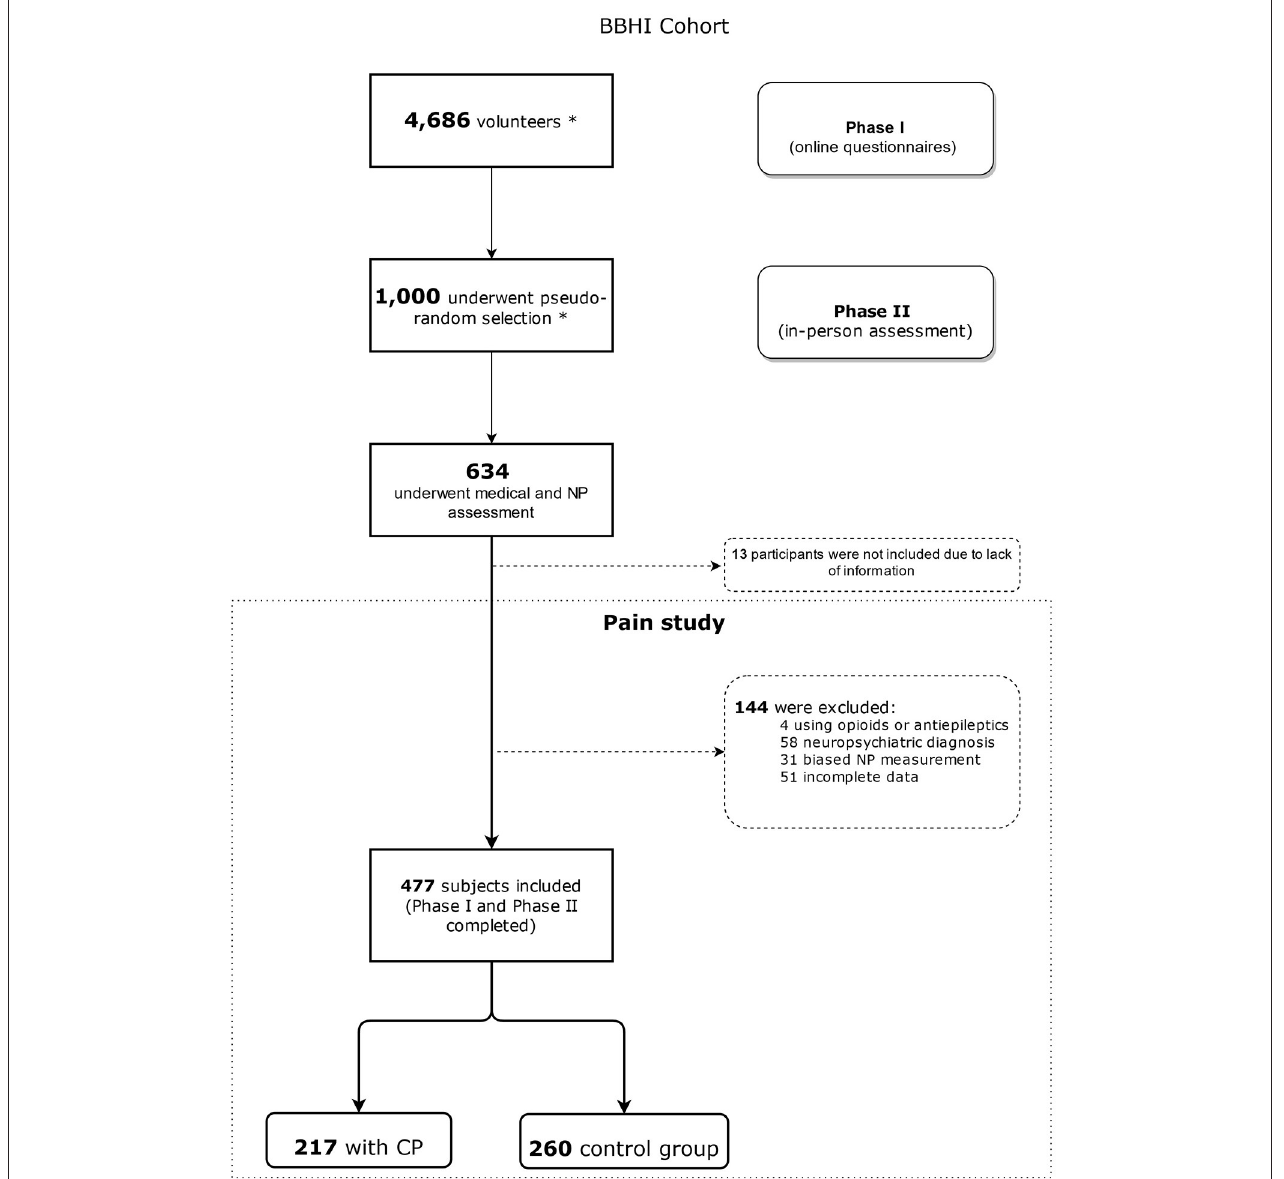
FIGURE 1 | Flowchart of the selection and distribution of patients in this study. BBHI, Barcelona Brain Health Initiative; NP, Neuropsychological; CP, Chronic Pain. *Volunteers were selected by BBHI methodology. For more detail information refer to Cattaneo et al. (2018, 2020). For this study, we selected participants enrolled in the project until February